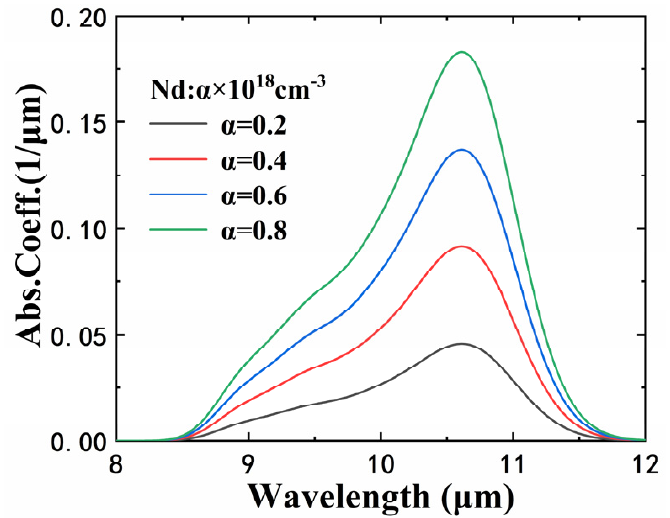
spectrum of the active region. Figure 9 shows the simulation results with different doping concentrations in the well. The absorption spectrum is taken into the software Comsol Multiphysics for the QE calculation of the final device.